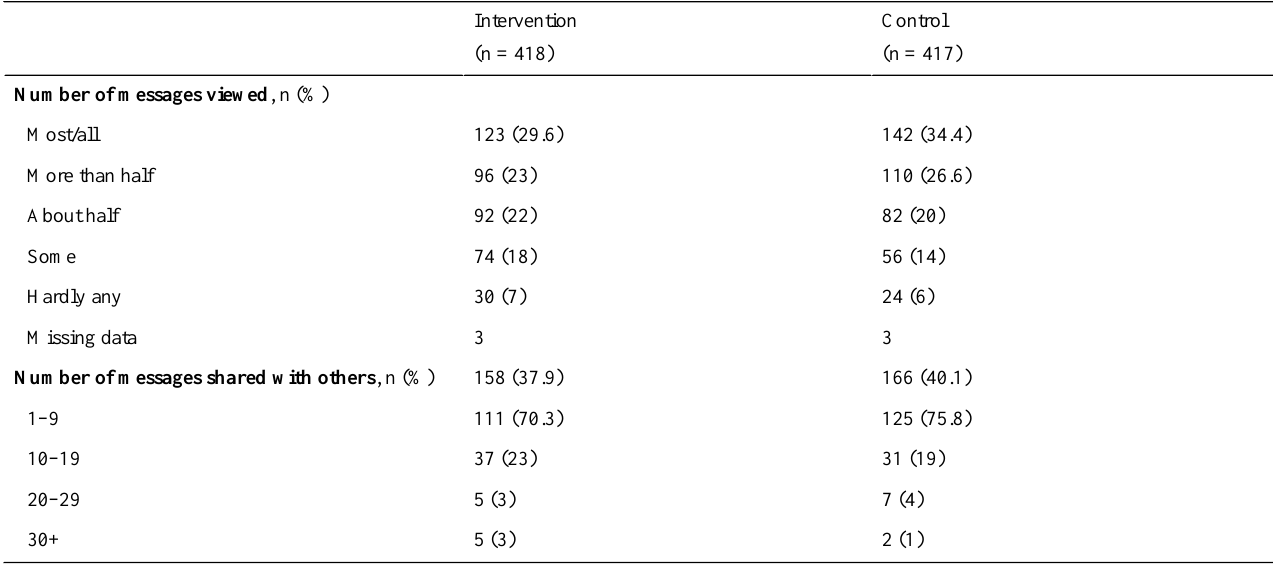
Table 2. Participant viewing and sharing of messages